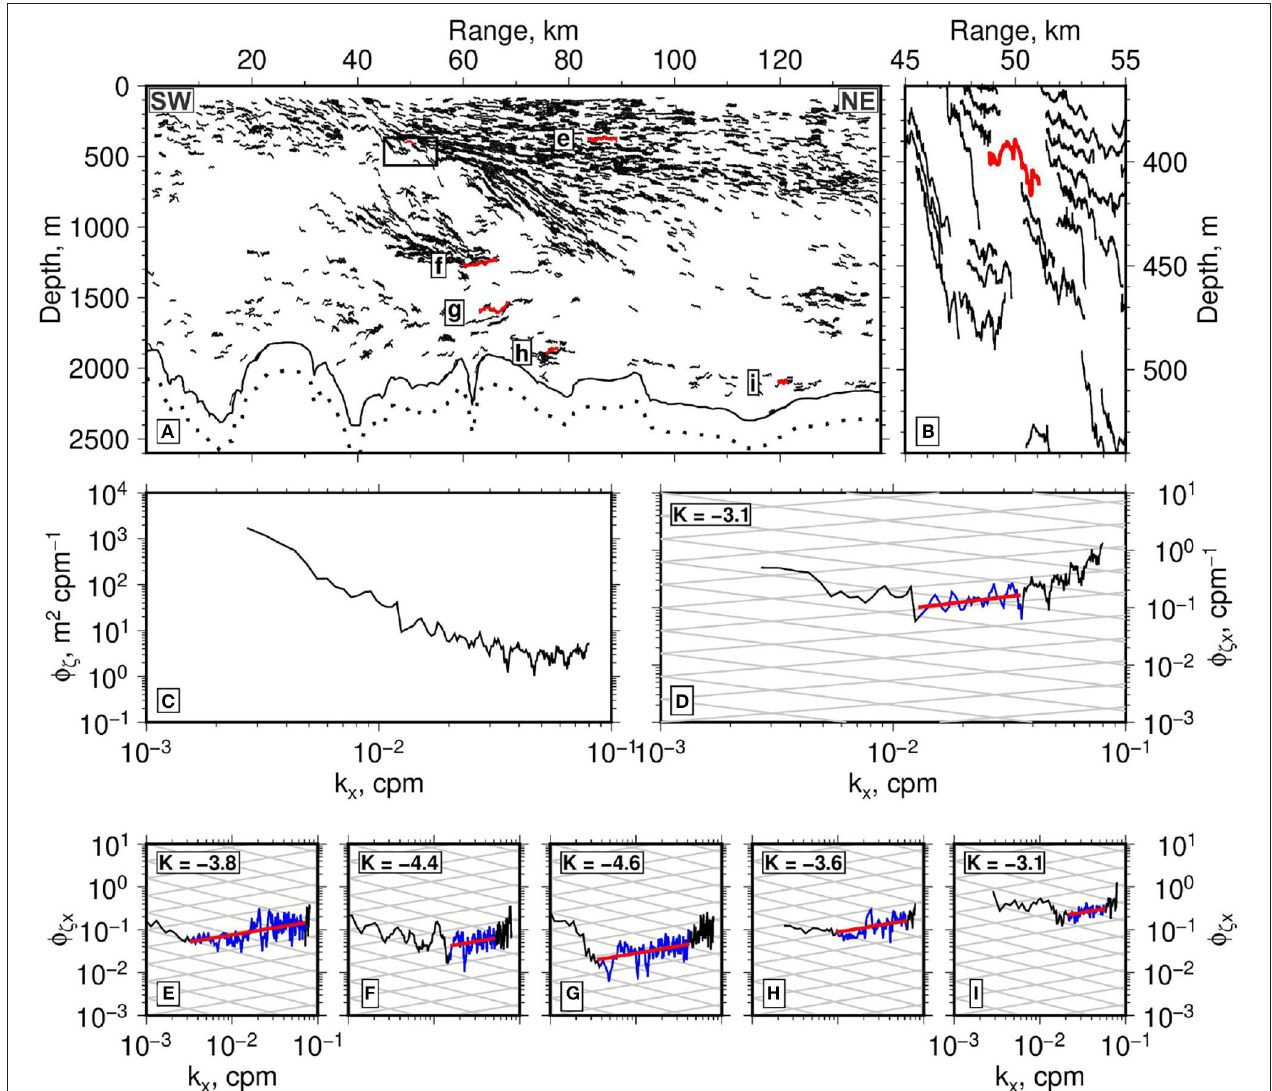
FIGURE 5 | (A) Auto-tracked version of section B. Black box = zoomed portion shown in (B,C) where red line = auto-tracked reflection analyzed in (C,D) ; labeled red lines = auto-tracked reflections that are spectrally analyzed in (E–I) . (B) Zoomed portion of (A) with auto-tracked reflection that is spectrally analyzed in (C,D) . (C) Power of vertical displacement, 8 ξ , plotted as function of horizontal wavenumber, k x , which has units of cycles per meter (cpm). Spectrum calculated using multi-taper Fourier transform of linearly detrended tracked reflection highlighted in (B) . Internal wave, turbulent, and noise subranges characterized by spectral slopes of − 2, − 5 / 3 and 0, respectively. (D) 8 ξ (i.e., 8 ξ × (2 π k x ) 2 ) plotted as function of k x . On this slope spectrum, black/blue/black lines = internal wave/turbulent/noise x subranges characterized by spectral slopes of − 1 / 2, + 1 / 3 and + 2, respectively; red line = best-fitting model of turbulent subrange; label in top right = calculated value of log 10 K ; gray reticule = slopes of internal wave and turbulent subranges with spectral gradients of − 1/2 and + 1 / 3, respectively. (E–I) Slope spectra for other auto-tracked reflections shown in (A) . Symbols and labels as for (D) .